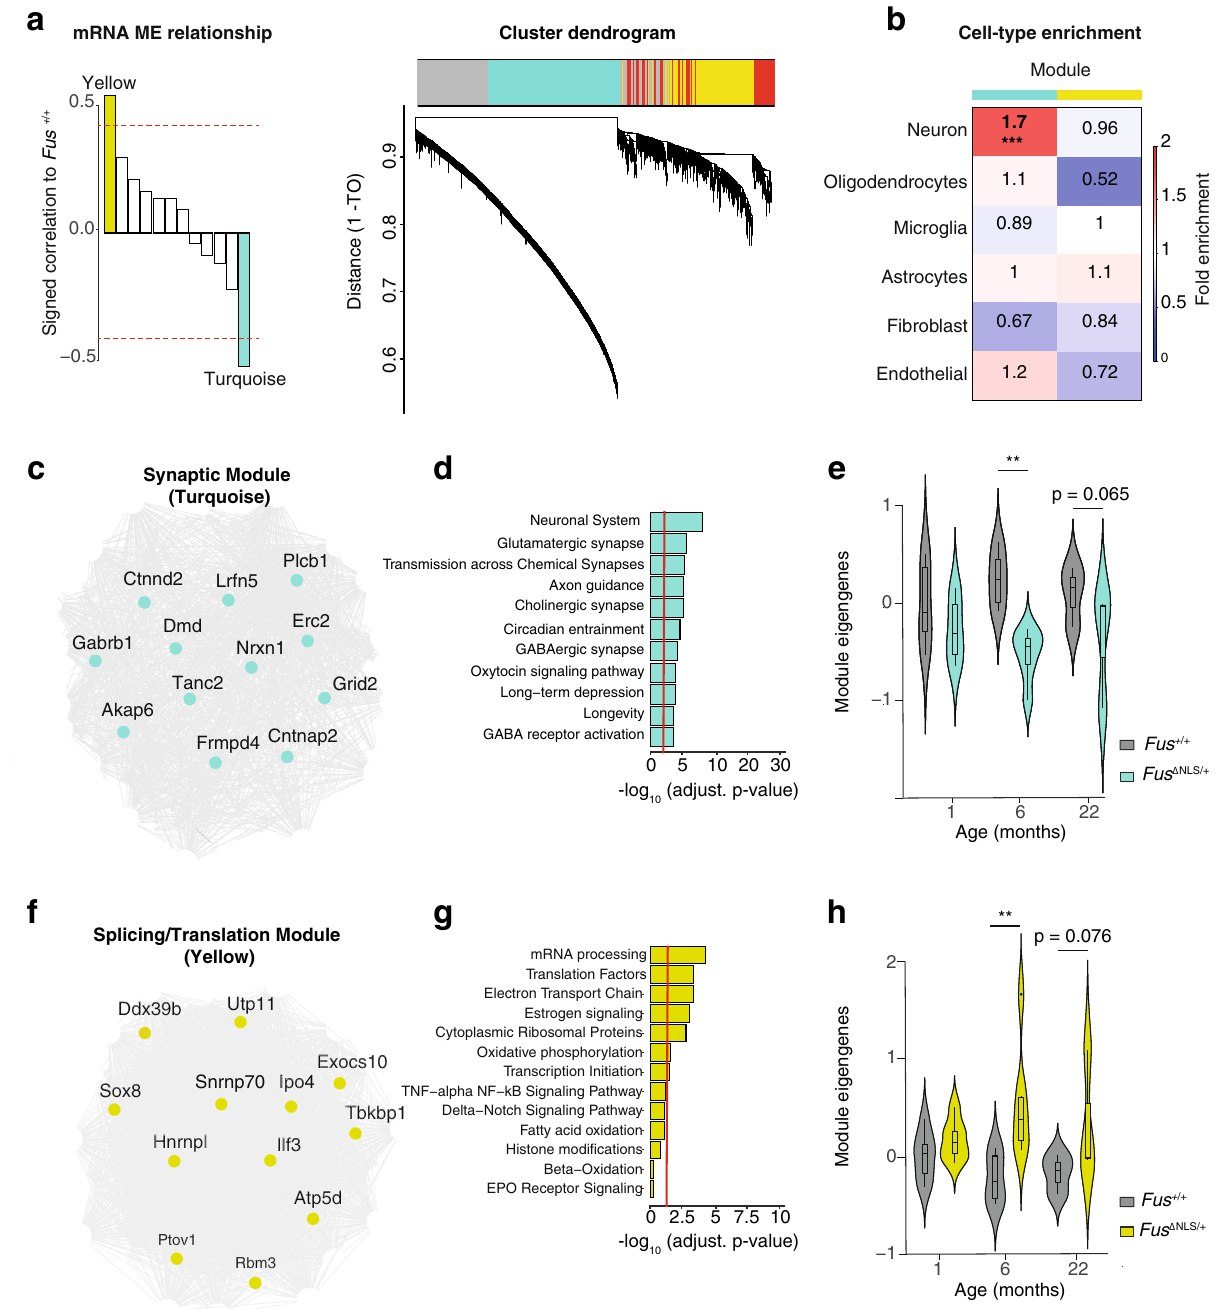
Fig. 5 mRNA coexpression network analysis pinpoints defects in inhibitory and excitatory synapses in Fus Δ NLS/ + mice. a Signed association (Pearson correlation) of the mRNA MEs with transgenic condition. Modules with positive values indicate increased expression in transgenic mice; modules with negative values indicate decreased expression in transgenic mice. The red dotted lines indicate Bonferroni-corrected P < 0.05 for multiple comparisons ( n = 12 modules, n = 16 mice per group). b Cell-type enrichment of modules (average n = 200 genes) using mouse genes in mRNA modules (Fisher ’ s two-tailed exact test, ***FDR = 2 × 10 − 5 ). c Coexpression network plot of the synaptic (turquoise) module. The top 12 hub genes are indicated by name. d Gene ontology term enrichment of the synaptic module using 1791 synaptic module genes. e Trajectory of the synaptic module in the cortex of Fus Δ NLS / + mice across time. Boxplot show median and quartile distributions, the upper and lower lines representing the 75th and 25th percentiles, respectively. Two-way ANOVA, F (1,24) = 14.55, p = 0.0008; n = 4 – 6 mice per group. f Coexpression network plot of the splicing/translation module. The top 12 hub genes are indicated by gene name. g GO term enrichment of the splicing/translation module using 1112 splicing/translation module genes. h Trajectory of the splicing/translation module in the cortex of Fus Δ NLS/ + mice across time. Boxplot show median and quartile distributions, the upper and lower lines representing the 75th and 25th percentiles, respectively. Two-way ANOVA, F (1,24) = 11.92, p = 0.002; n = 4 – 6 mice per group. The center line represents the